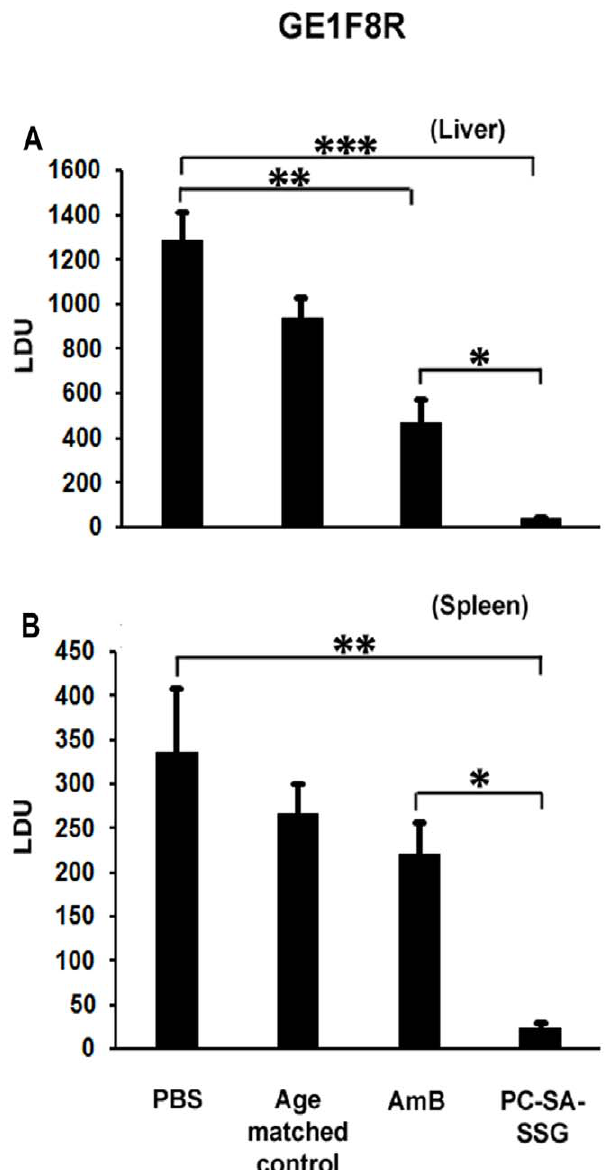
Figure 2. Parasite burden in cured BALB/c mice after reinfec- tion with L.donovani. Cured mice (PC-SA-SSG and AmB treated) after 4 weeks of treatment along with naı¨ve age-matched controls were reinfected with similar dose of virulent amastigotes and at 20 weeks of primary infection, were sacrificed and liver (A) and spleen (B) parasitic loads were determined by stamp-smear method and expressed as Leishman Donovan Units (LDU). Data represent mean 6 SEM (n=3-5 mice per group), representative of two similar experiments. * p , 0.05; ** p , 0.01; *** p , 0.001.